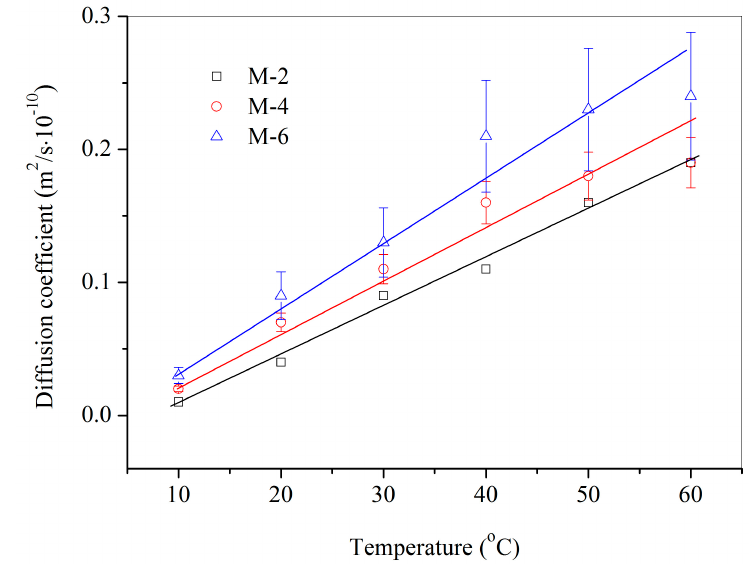
Figure 9. Diffusion coefficient values of microcapsules (content of 6%) in bitumen with different mean size values (samples of M-2, M-4 and M-6) under a temperature range of 10 °C–60 °C.